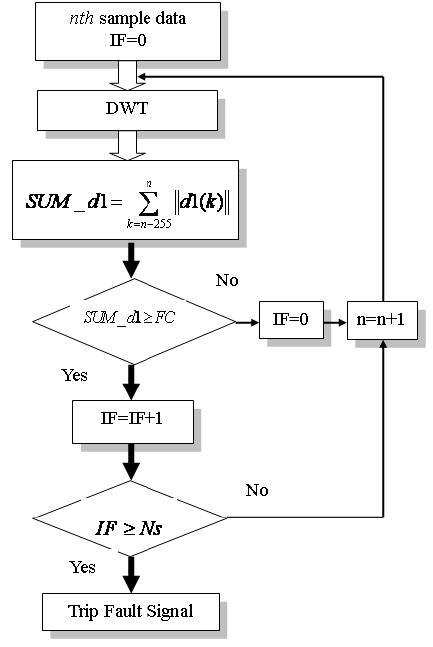
Figure 5. Block diagram of fault detection.